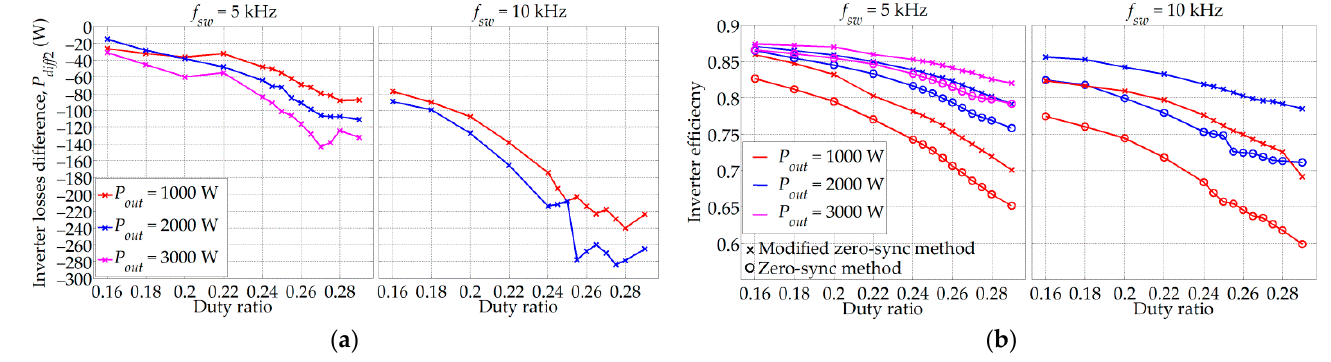
Figure 18. Inverter losses difference ( P diff 2 ) ( a ) and inverter efficiency ( b ) as a function of the duty ratio for the different values of the load power and switching frequency.